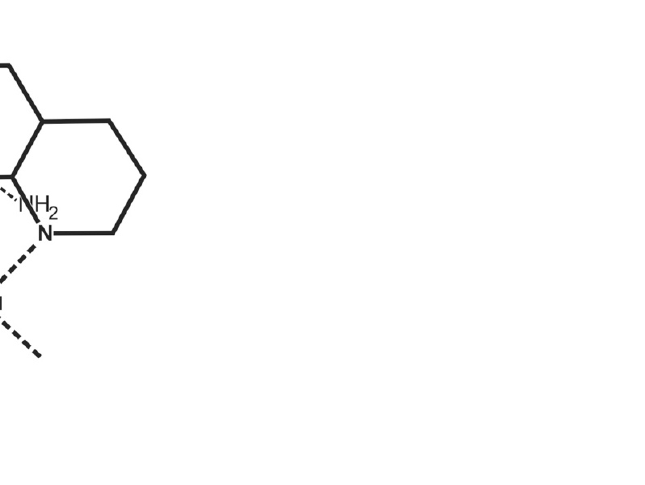
Figure 17. Tentative and simplified structure of a species with an intramolecular stack for Cu(phen)(PMEA) in solution [45,141]. Adapted from Ref [45].